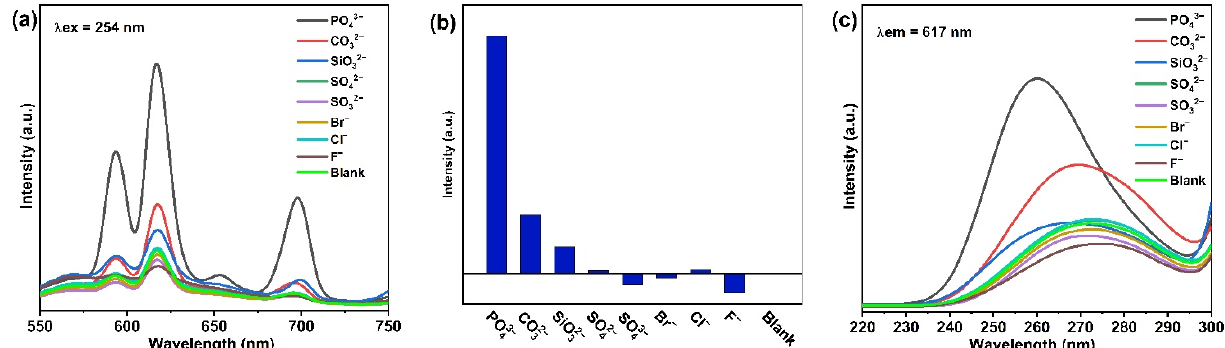
Figure 3. ( a ) Emission spectra ( λ ex = 254 nm) of different anions at the excitation wavelength of 254 nm; ( b ) Luminescence intensity of the characteristic emission peak at 617 nm was selected for comparison; ( c ) Excitation spectra ( λ em = 617 nm) of different anions at emission wavelengths of 617 nm.